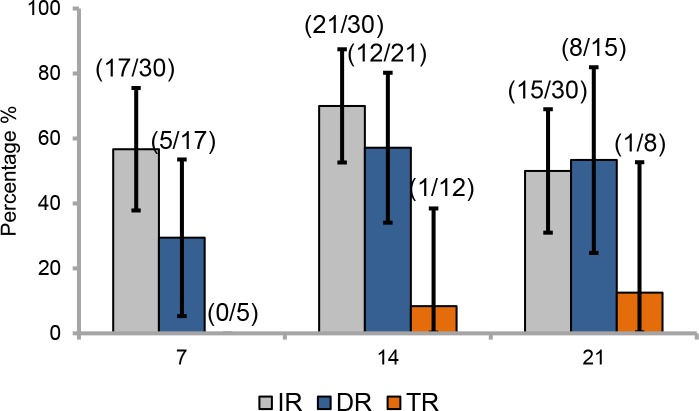
Infection, dissemination and transmission rates of Aedes aegypti guadeloupe to YFV (IEC-4408, 1E lineage).Mosquitoes were exposed to an infectious blood meal with YFV provided at a titer of 106.5 ffu/mL. After infection, mosquitoes were examined at 7, 14, and 21 days post-infection. Error bars show the 95% confidence interval. In brackets, the number of mosquitoes examined. IR: the proportion of mosquitoes with infected body among engorged mosquitoes; DR: the proportion of mosquitoes with infected head among mosquitoes with infected body; TR: the proportion of mosquitoes with infectious saliva among mosquitoes with infected head.